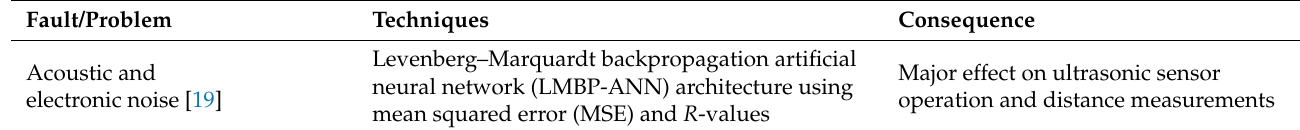
Table 7. Demonstration of ultrasonic sensor fault types and their detection